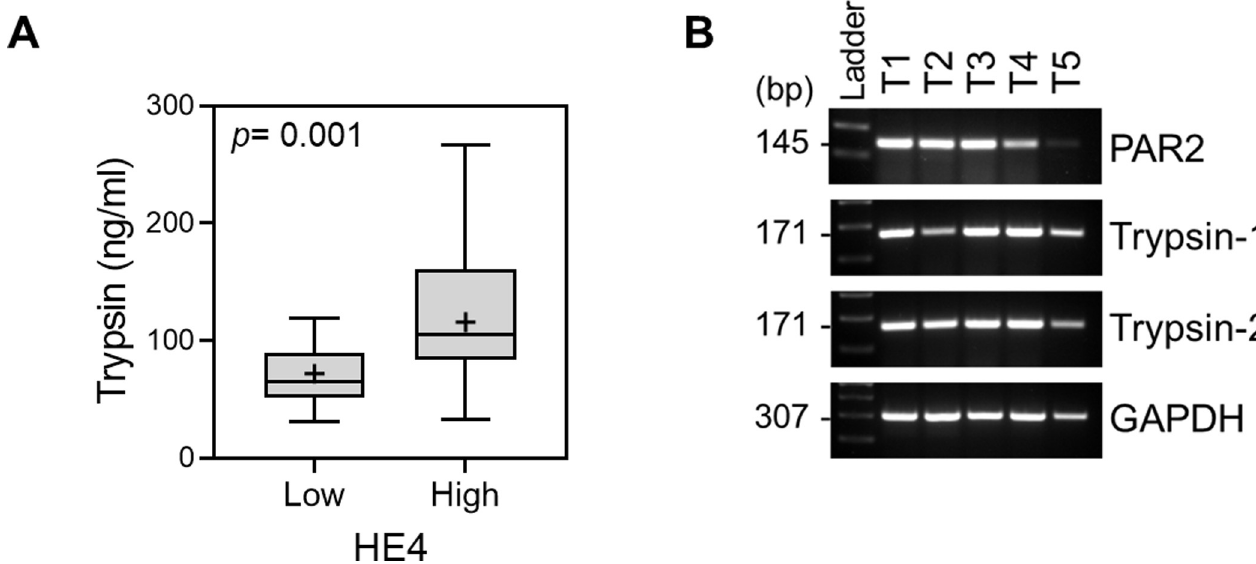
Fig 6. Trypsin levels are elevated in a group with higher HE4. (A) Serums from patients with ovarian cancer were analyzed for trypsin expression by human pan-trypsin specific enzyme-linked immunosorbent assay. See Methods for detailed protocols. Each HE4 group was stratified by pre-determined HE4 concentrations (HE4 cut-off = 100 pM). unpaired, two-tailed Welch’s t test (high vs. low); Sample size: HE4 high ( N = 28); HE4 low ( N = 15). (B) Expression of PAR2 and trypsin-1/2 in ovarian cancer patient tissues (T1-T5) was determined by semiquantitative RT-PCR. GAPDH expression served as a loading control.